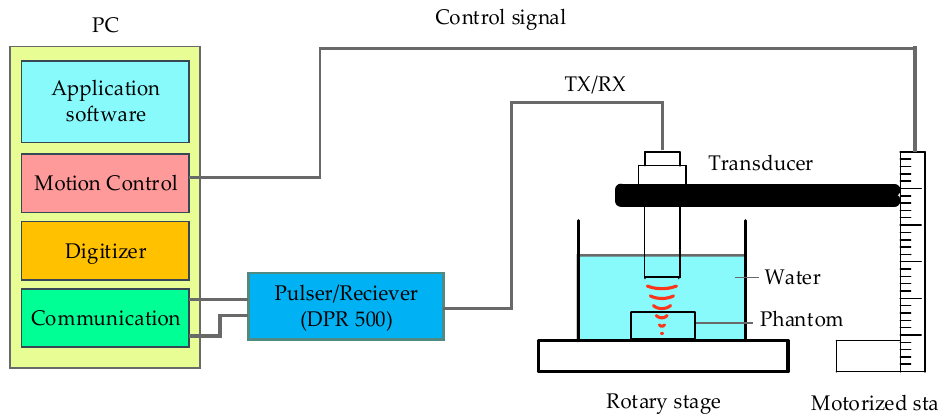
Figure 6. The schematic diagram of the experiment for the wire phantom using MFP transducer.